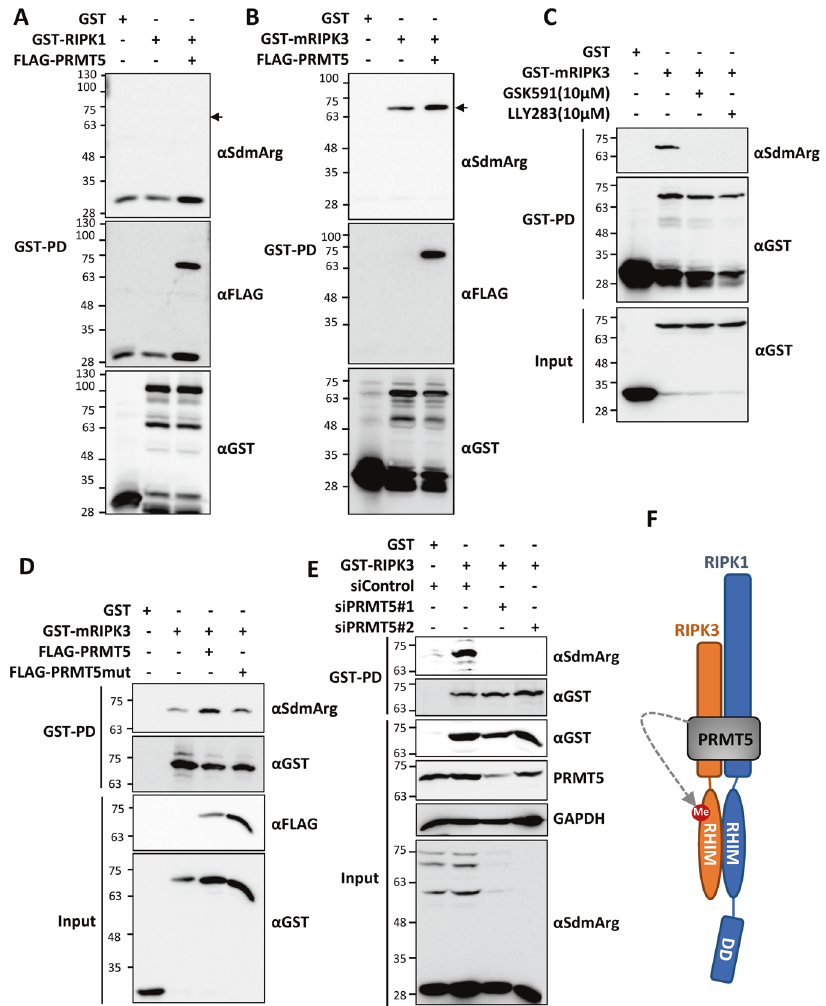
Fig. 2 RIPK3 is a target of PRMT5-mediated symmetric arginine dimethylation. GST-enrichment and probing with antibodies against symmetric dimethyl arginine ( α SdmArg) to monitor PRMT5-mediated dimethylation of mRIPK1 ( A ) and mRIPK3 ( B ). C Effect of PRMT5 inhibitors GSK591 and LLY283 on RIPK3 methylation monitored by GST-enrichment and immunoblotting (inhibitor treatment: last 6 h before cell lysis). D FLAG-tagged wild-type PRMT5 but not the catalytic-de fi cient PRMT5 mutant (PRMT5mut, R368A) is capable of enhancing RIPK3 arginine methylation. E siRNA mediated depletion of PRMT5 suppresses symmetric dimethylation of mRIPK3 in HEK293T cells. Ef fi cient depletion of PRMT5 is shown by PRMT5 immunoblots and detection of methylated proteins in the total cell lysates F While both RIPK1 and RIPK3 interact with PRMT5, only RIPK3 is a substrate of symmetric arginine dimethylation. (Supplementary Fig. S5B). When necroptotic signaling was compared between the four cell lines, we observed clear rescued RIPK1 autophosphorylation and suppressed necroptotic signaling, suggesting that the RIPK3-mediated feedback control on RIPK1 activation requires RIPK3 kinase activity. Moreover, inhibitors of oligomerization of both RIPK3 (PP2) and MLKL (NSA) also inhibited necroptotic signaling as well as RIPK3-mediated suppression of RIPK1-S166 phosphorylation (Fig. 4A). wild-type (WT) and methylation-de fi cient mutants (R486K or R486A) of RIPK3. After transduction and selection of cell lines for uniform transduction, the selected empty vector and RIPK3 expression lines showed similar expression levels of GFP expressed from the bidirectional promotor demonstrating uniform transduction and similar expression levels of WT and mutant RIPK3 expression (Supplementary Fig. S5A). Moreover, necroptosis- resistant PANC1 cells were sensitized to RIPK1/RIPK3/MLKL- dependent necroptosis upon lentiviral rescue of RIPK3 expression Cell Death Discovery (2023)